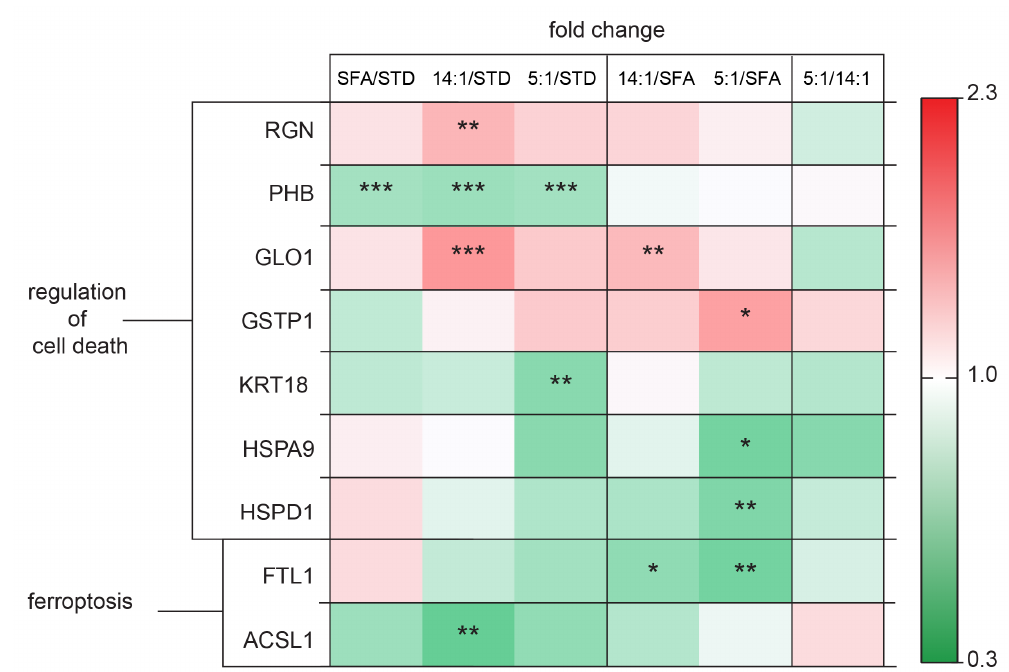
Figure 10. Changes in proteins involved in cell death processes. The statistically significant ( p < 0.05) value of the average intensity of the SFA, 14:1 and 5:1 groups compared to the STD group; the 14:1 and 5:1 groups compared to the SFA group; the 5:1 group compared to the 14:1 group. The significance of differences estimated using the model (1). *— p < 0.05; **— p < 0.01; ***— p < 0.001.